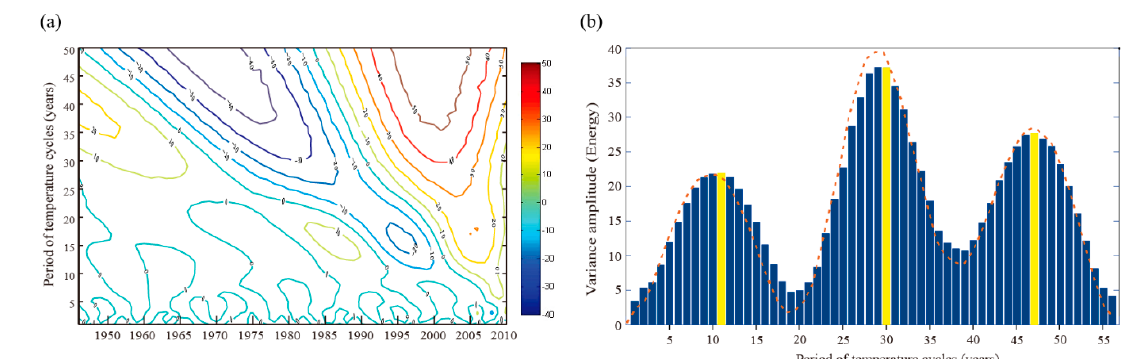
Figure 2. Results of the Morlet continuous wavelet transform analysis ( a ) and variances analysis ( b ). The yellow bars in ( b ) indicate the possible period of temperature cycles.